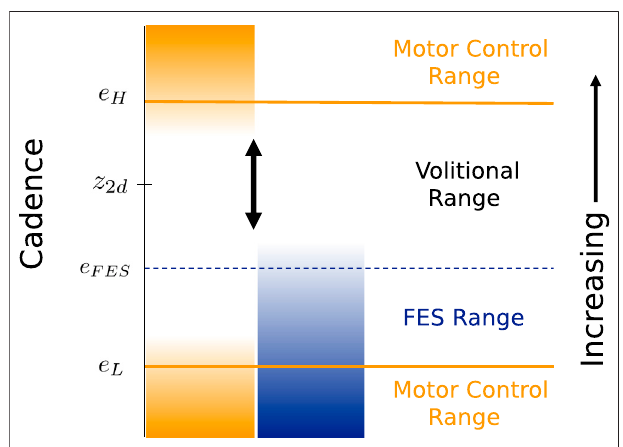
FIGURE 1 | Illustration of the regions of applied control effort as a function of cadence. No control effort is applied in the volitional range near the setpoint z 2d . The electric motor control input increases when the cadence approaches the boundaries de fi ned by e H and e L , and the FES control signal does the same near e FES . The size of each region is adjustable. The cadence range between e H and e L is rendered asymptotically stable by the developed control